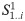
Recursion scheme to maximize intermolecular base pairs between two RNAs S1 and S2 represented in orange/blue, respectively.The optimal number for the interaction of S1..i1 and Sj..n2 is identified based on a distinction whether or not the ends Si1 and Sj2 might form a base pair or not.